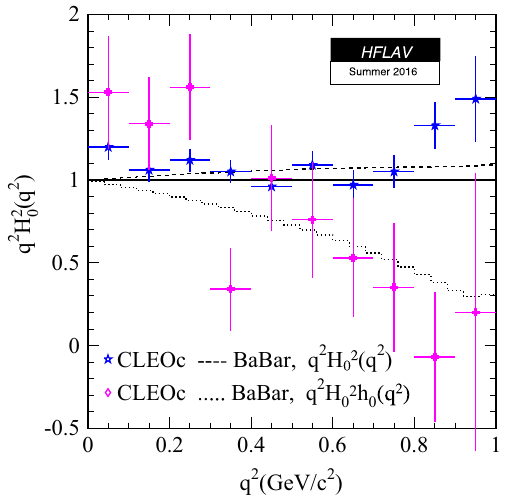
Fig. 203 Comparison between CLEO-c and BaBar results for the ( q 2 ) and q 2 h ( q 2 ) H ( q 2 ) quantities q 2 H 2 0 0 0 Table 280 Results for r V and r 2 from various experiments Experiment